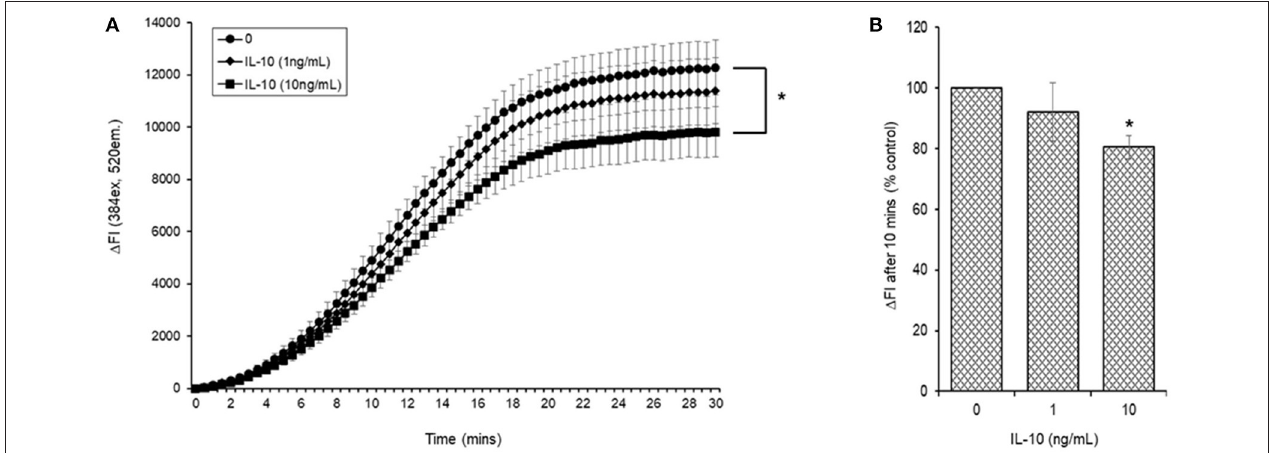
FIGURE 7 | AAPH-stimulated reactive oxygen species (ROS) generation in a differentiated mouse myotubule cell-line after 24h incubation in the absence or presence of IL-10. Results are presented as a (A) change in fluorescence intensity ( 1 FI; excitation [Ex.] 384nm, emission [Em.] 520nm) over 30min and (B) mean change in fluorescence intensity after 10min (% AAPH control). Results are mean ± SEM of six separate experiments. * p < 0.05 represents statistical difference from AAPH control.